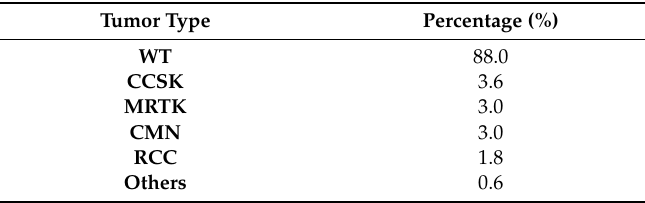
Table 1. Distribution of pediatric renal tumors in children < 15 year of age according to the National Registry Childhood Tumors